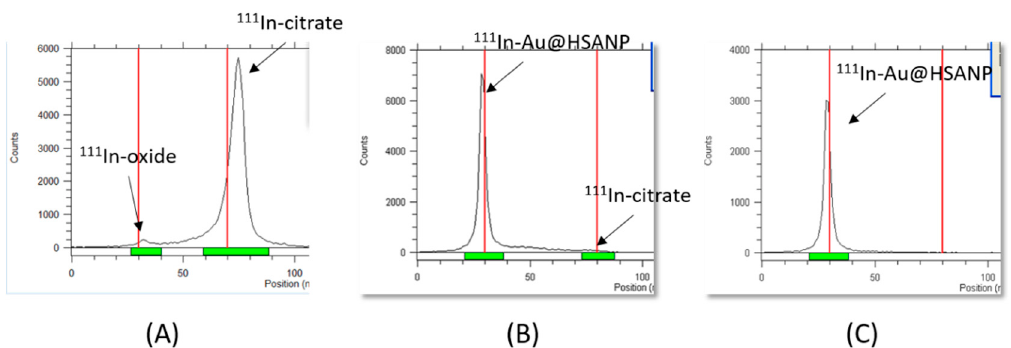
Figure 3. The characteristics of 111 In-Au@HSANP . ( A ) The iTLC result of 111 InCl 3 using 0.5 M sodium citrate (pH 5.0) as a developing agent; ( B ) the radiolabeling efficiency of 111 In-Au@HSANP was 95.3 ± 2.1%; ( C ) after passing through a Sepharose 4B gel column, the radiochemical purity of the purified 111 In-Au@HSANPs was >95%.